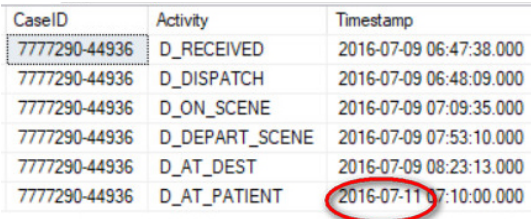
Figure 4. Exceptional case duration due to event timestamp data entry error.